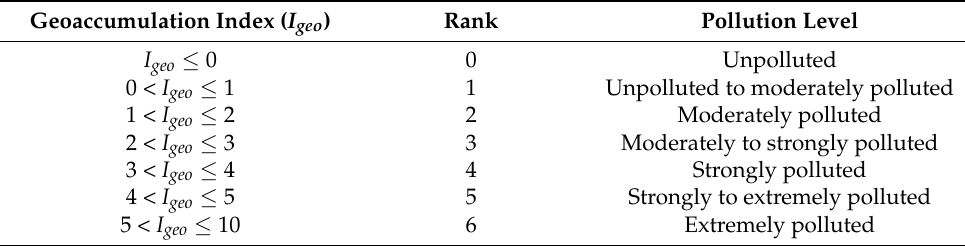
Table 3. Geo-Accumulation Index ( I geo ) and classification of pollution level.